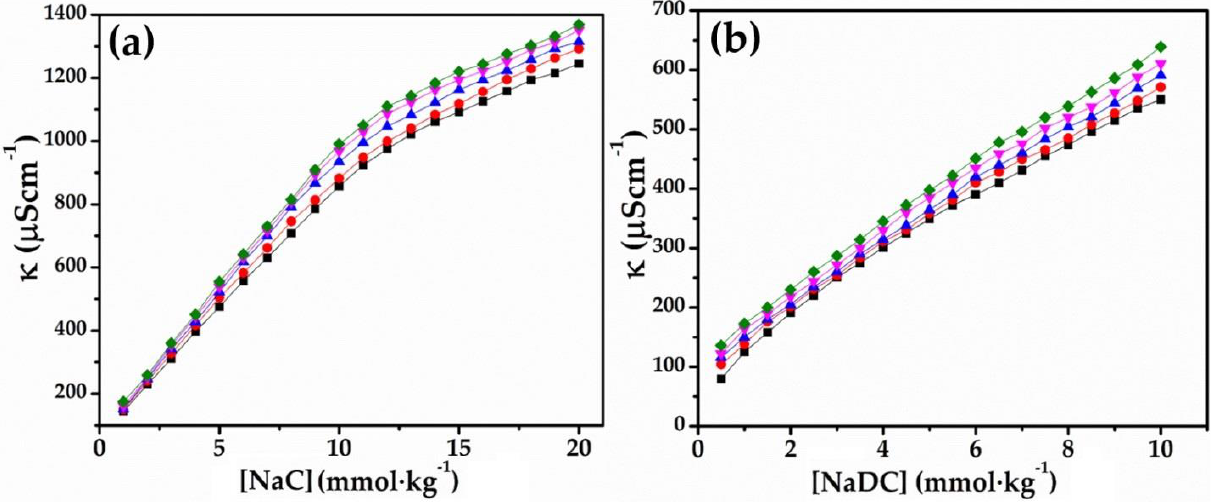
Figure 2. Illustrative plots of κ , as a function of concentration of ( a ) NaC and ( b ) NaDC in aqueous 0.010 mol∙kg -1 Glycyl dipeptide at 298.15 K ( ■ ), 303.15 K ( ● ), 308.15 K ( ▲ ), 313.15 K ( ▼ ), and 318.15 K ( ◄ ).